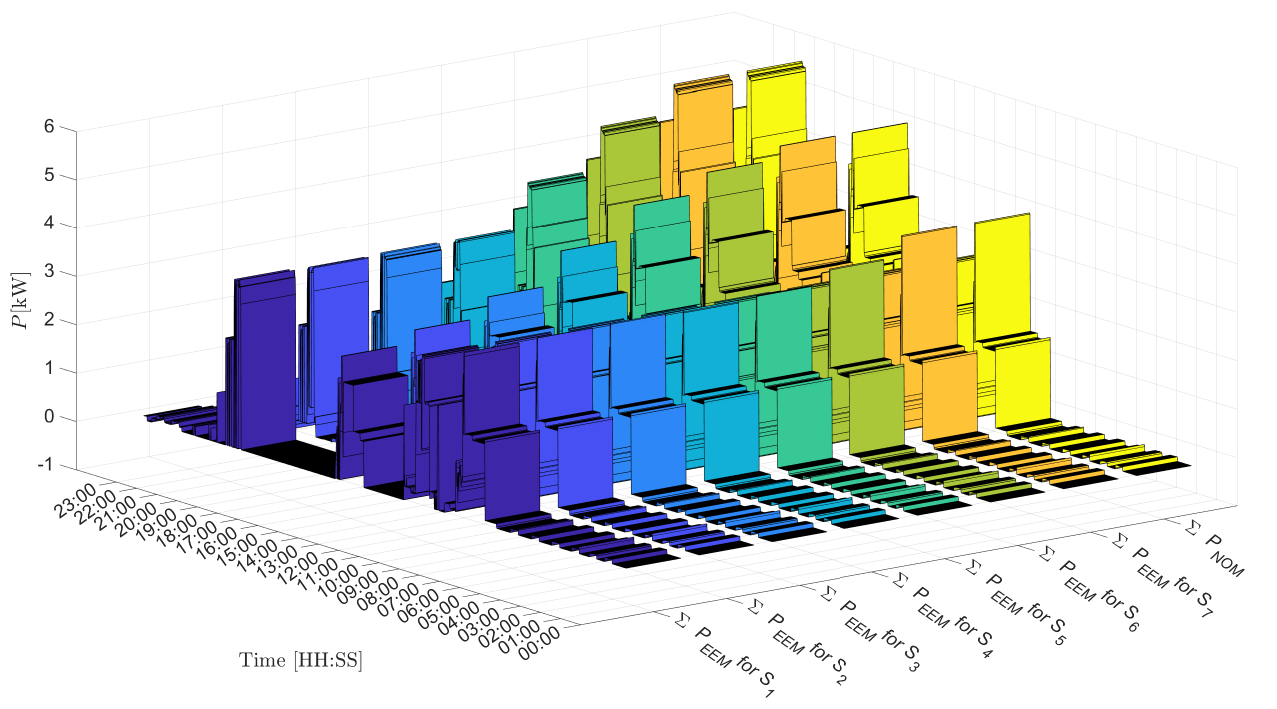
Figure 13. Simulation test results for all defined S .